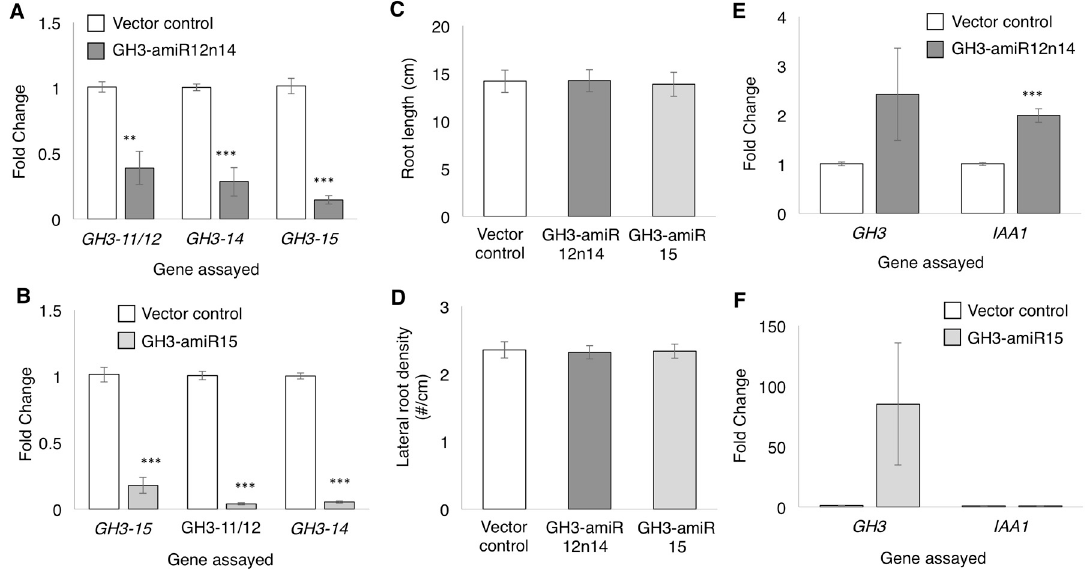
Figure 6. Suppression of GmGH3 expression by artificial microRNAs. ( A , B ) Expression of target GmGH3 genes in roots expressing ( A ) GH3-amiR12n14 and ( B ) GH3-amiR15 relative to vector control roots; ( C ) Root length and ( D ) lateral root density of vector control roots and roots expressing GH3-amiRs. Data shown are averages ( n = 21) and error bars indicate SEM. No significant difference observed using Student’s t -test; ( E , F ) Expression of auxin response marker genes GH3 and IAA1 in roots expressing ( E ) GH3-amiR12n14; and ( F ) GH3-amiR15, relative to vector control roots. Expression levels shown in ( A , B , E , F ) were assayed by RT-qPCR and normalized to that of Actin in each sample. Data shown are average relative expression values (fold change vs. vector control) from three biological replicates and error bars indicate the range of possible value based on SD between replicates. ** p < 0.01, *** p < 0.001, Wilcoxon-Mann-Whitney test.